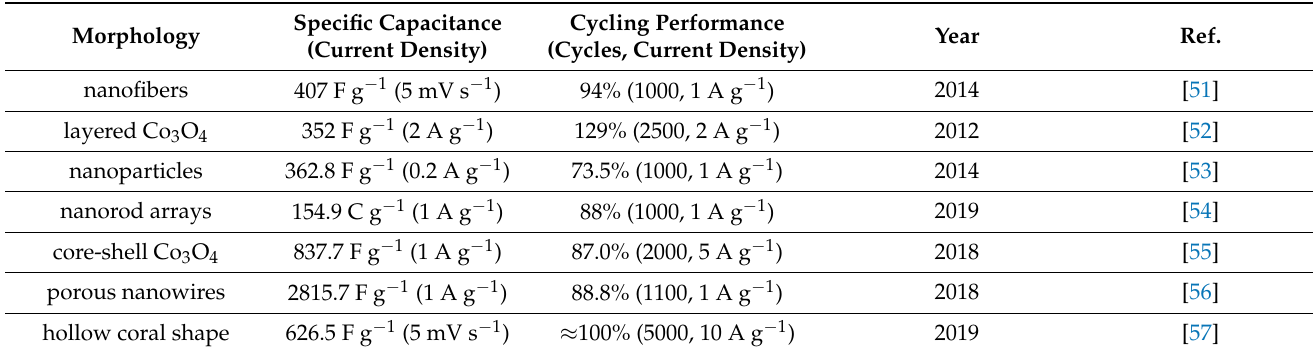
Table 1. Electrochemical properties of each microscopic